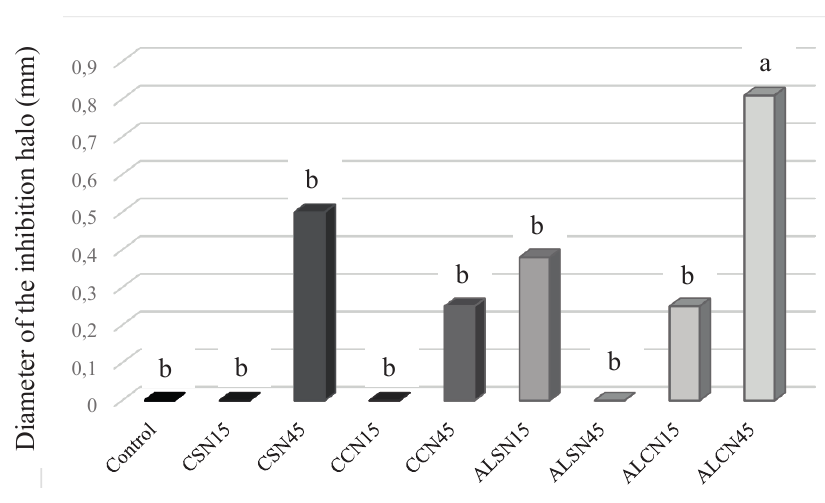
Figure 2. Quantity in mm of inhibition halo formed around paper discs soaked in ethanol extracts of guava leaves from treatments with or without Acaulospora longula (AL) (C), with (CN) or without (SN) Meloidogyne , control (70% alcohol), at 15 or 45 days of the experiment, on plates containing the Klebsiella pneumoniae carbapenemase bacterium (SD = 0.4). Averages followed by the same letter are not statistically signifi cant (Duncan’s post-hoc test, alpha of